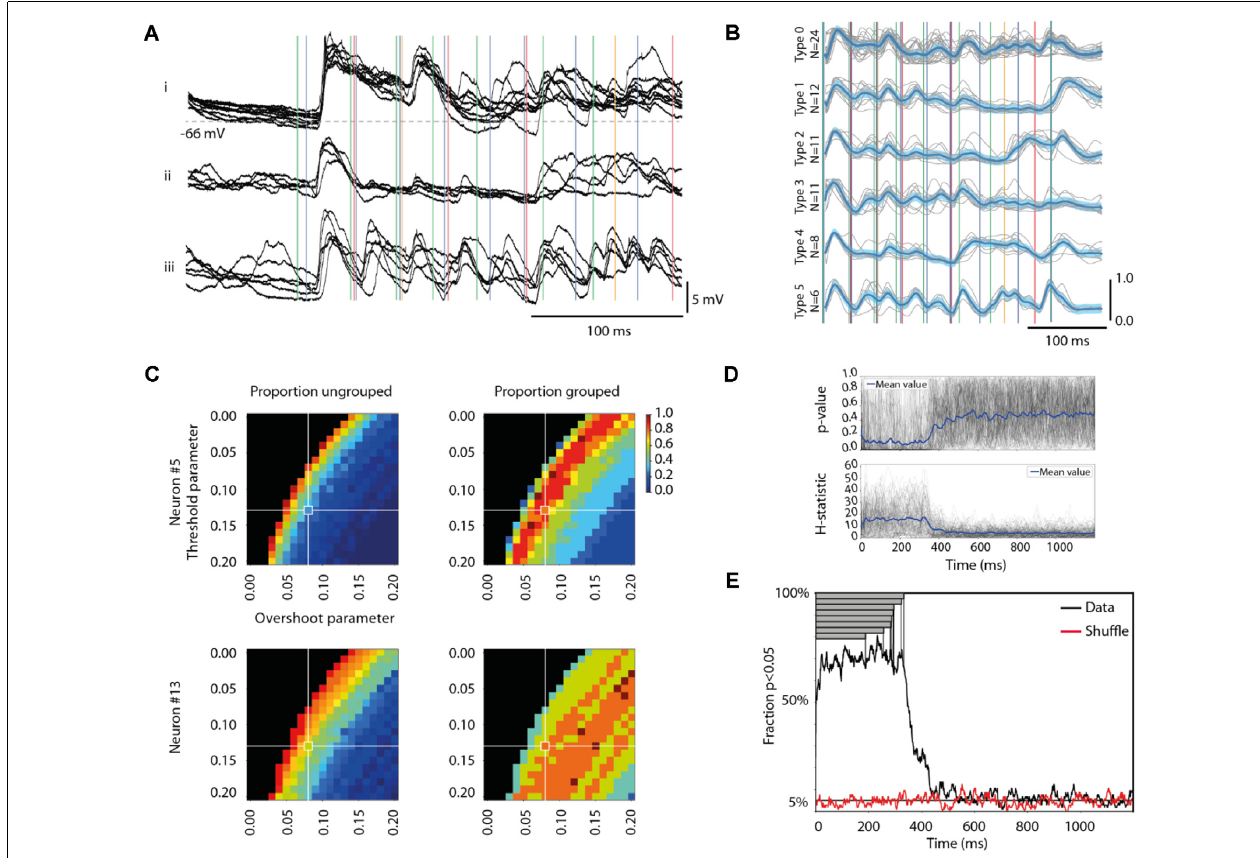
FIGURE 2 | Different response types evoked by the same stimulation pattern. (A) Each panel i-iii shows, for a sample cell (Neuron #5), examples of qualitatively different superimposed raw data traces, evoked by the same stimulation pattern (S5). Note that the stimulation pattern (vertical colored lines) outlasted the traces. Stimulus artifacts are reduced for clarity. (B) The six identified response types for all responses evoked by the 100 repetitions of this stimulation pattern in this cell are shown separately. The mean response of each type is indicated by the thick blue curve, the threshold difference by the light blue span, and the raw traces are indicated in gray, alongside the stimulation pattern. (C) Sensitivity analysis of the parameter settings (for “Threshold” and “Overshoot”, respectively, see “Materials and Methods” section) of our response type classification/clustering method illustrated for two different neurons. The impact of the parameter settings on the fraction of responses ending up as ungrouped (proportion ungrouped) and on the number of response types identified vs. the maximal number of response types identifiable within the parameter space (proportion grouped) are illustrated for both sample neurons (Neuron #5 is also illustrated in panels A,B ). Note that the parameter settings used for the main analysis are indicated by the cross-hairs. (D) The Kruskal Wallis test result of the separation between the members of each response type from the members of other response types evoked by the same stimulation pattern in the same neuron, plotted as a separate time curve for each stimulation pattern ( N = 104; gray traces). The blue trace represents the average across all stimulation patterns. The corresponding plot for the H statistic is shown in the diagram below. (E) Time evolution of the specificity of the responses of each response type. The black curve is the fraction of all response types where specificity could be detected (at p < 0.05, Kruskal-Wallis test). The red curve shows the corresponding fraction for responses with shuffled response type labels (within each stimulation pattern, for each cell). Gray bars show the durations of the eight stimulation